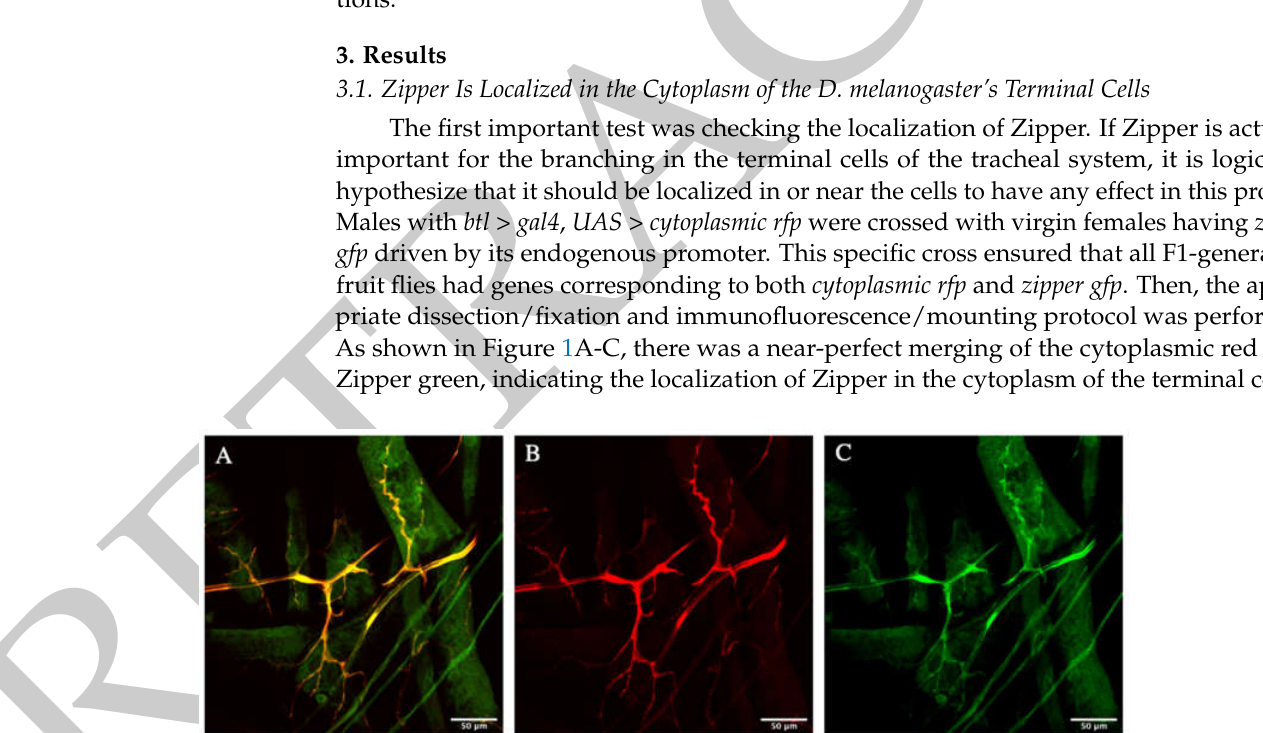
Figure 1. Localization of Zipper in cytoplasm. ( A ) is a merged photo of Zipper in the cytoplasm of the terminal cell in Drosophila melanogaster . ( B ) is a photo of the same terminal cell in D. melanogaster with only the cytoplasmic RFP signal. ( C ) demonstrates the same terminal cell with only the Zipper GFP signal.